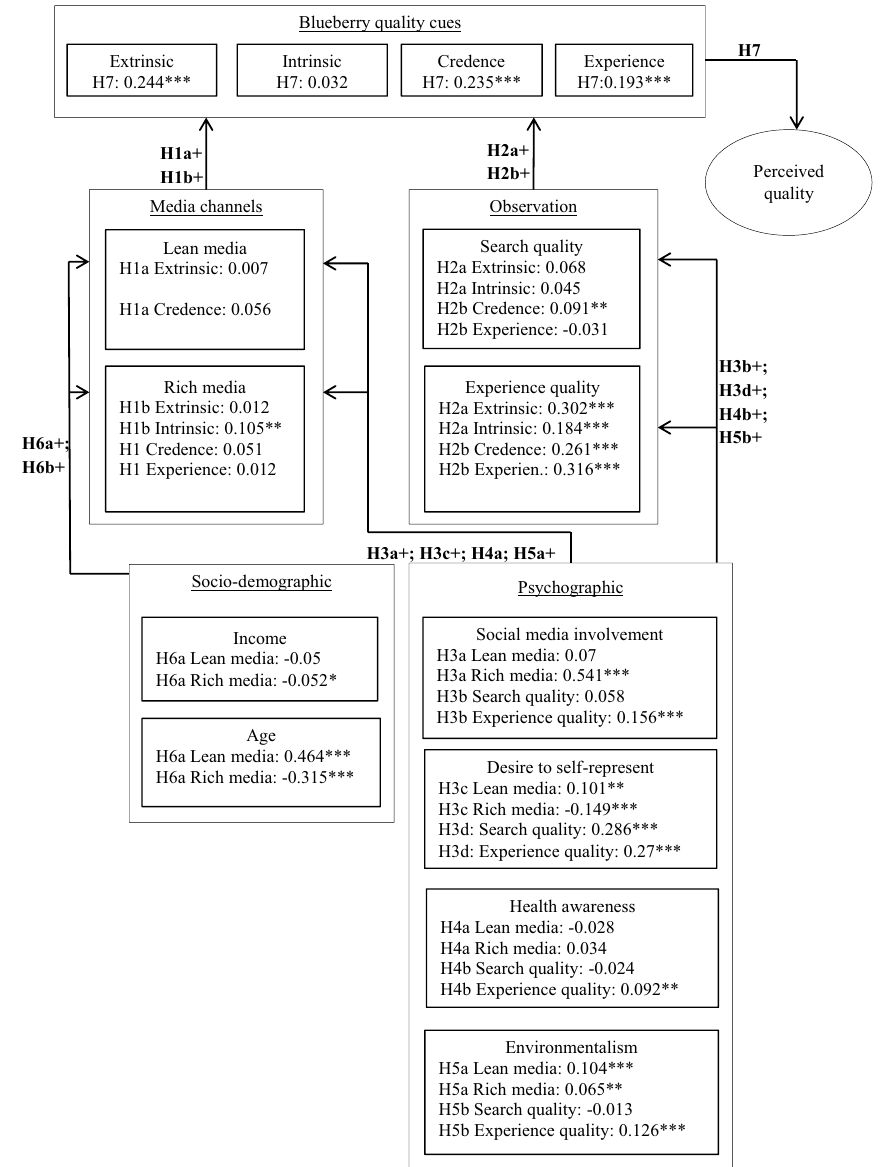
Fig. 3 Determinants of NHLFP quality perception. Source : Authors’ own graphic adapted from Luning, Marcelis, and Jongen (2002) and Otter, Prechtel, and Theuvsen (2018). The numbers in parentheses represent path coefficients; level of significance: *